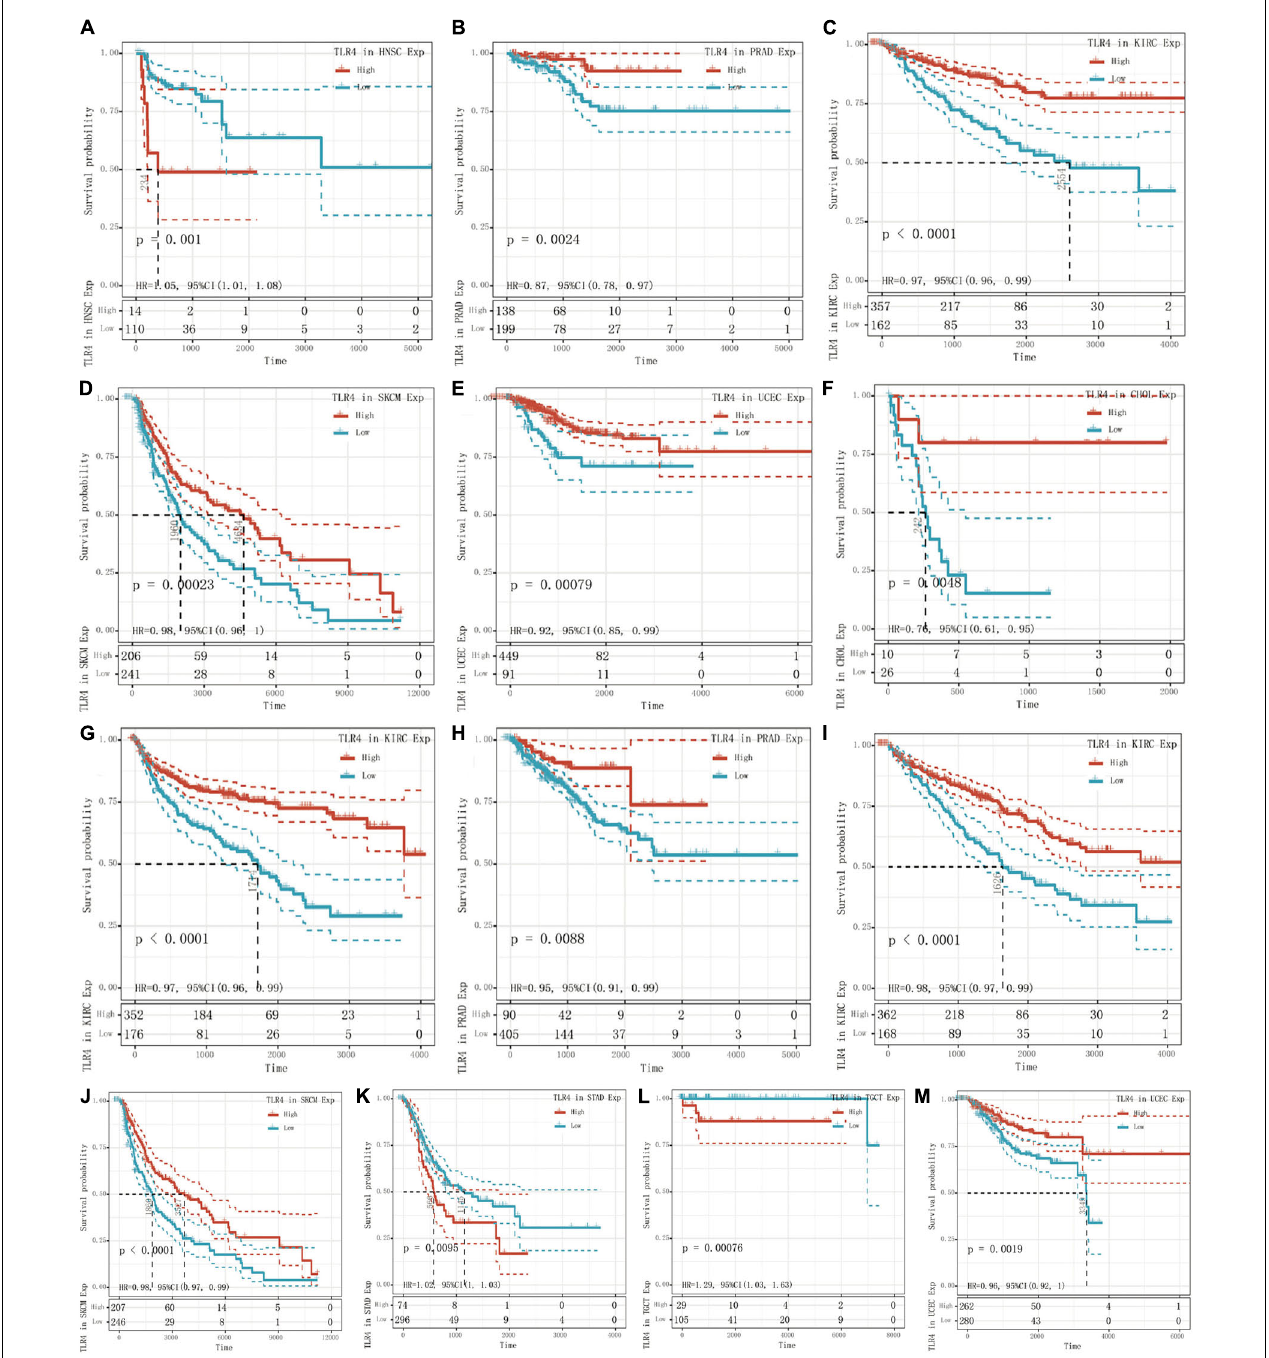
FIGURE 2 | Survival curve of cancer types with significant correlation between TLR4 gene expression and prognosis. The low expression of TLR4 was related to the low survival rate of KIRC ( p < 0.0001) (C,G,I) , SKCM ( p = 0.00023) (D,J) , UCEC ( p = 0.00079) (E,M) , and CHOL ( p = 0.0048) (F) . High TLR4 expression is related to low survival rates of HNSC ( p = 0.001) (A) , PRAD ( p = 0.0024) (B,H) , STAD ( p = 0.0095) (K) , and TGCT ( p = 0.00076) (L) .